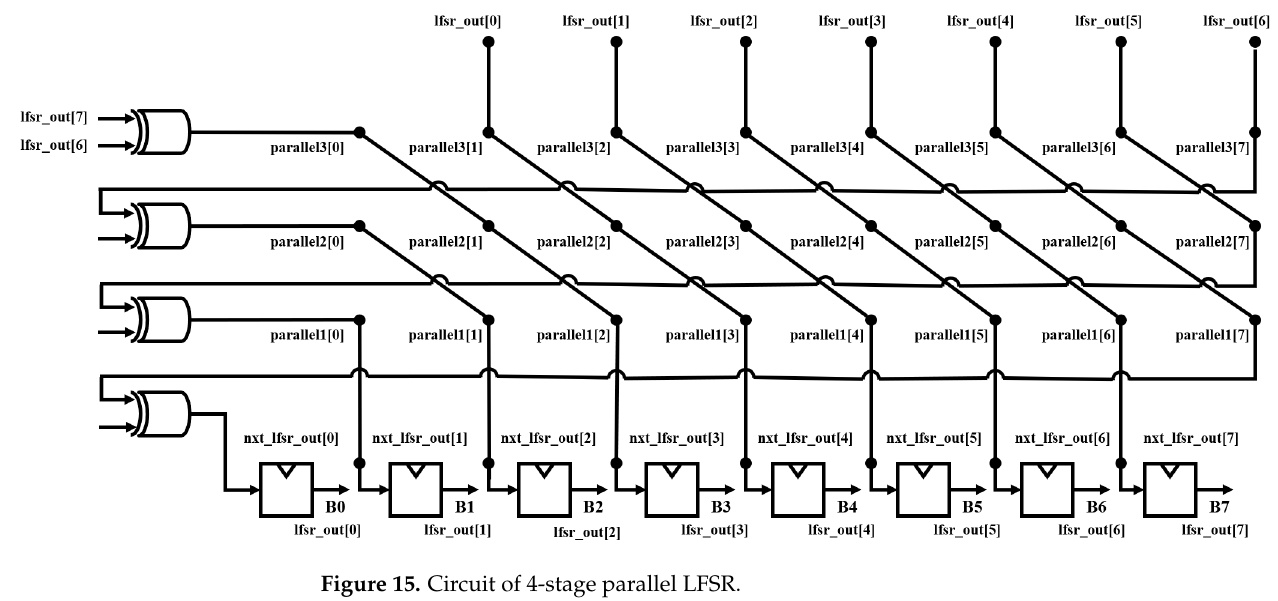
Figure 15. Circuit of 4-stage parallel LFSR.